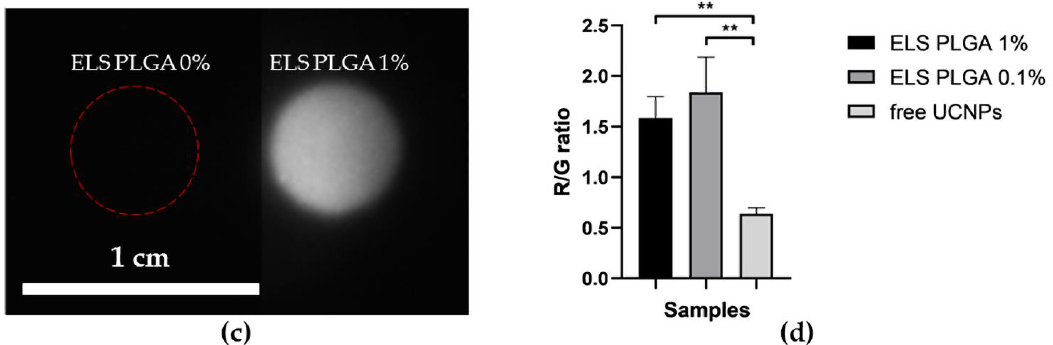
Figure 7. Electrospun polylactic-co-glycolic acid scaffolds: SEM image ( a ); normalized photoluminescence spectra of the UCNPs and the UCNPs included in ELS PLGA scaffolds ( b ); photographs of ELS PLGA scaffolds with 0 (control) and 1 mg of UCNPs per 100 mg of polymer at 976 nm ( c ). Ratio of the intensity of the red peak at 658 nm to the intensity of the green at a wavelength of 544 nm of UCNPs and ELS PLGA scaffolds (0.1 and 1% UCNPs) * p < 0.05, ** p < 0.01 in Student ’ s t-test ( d ).